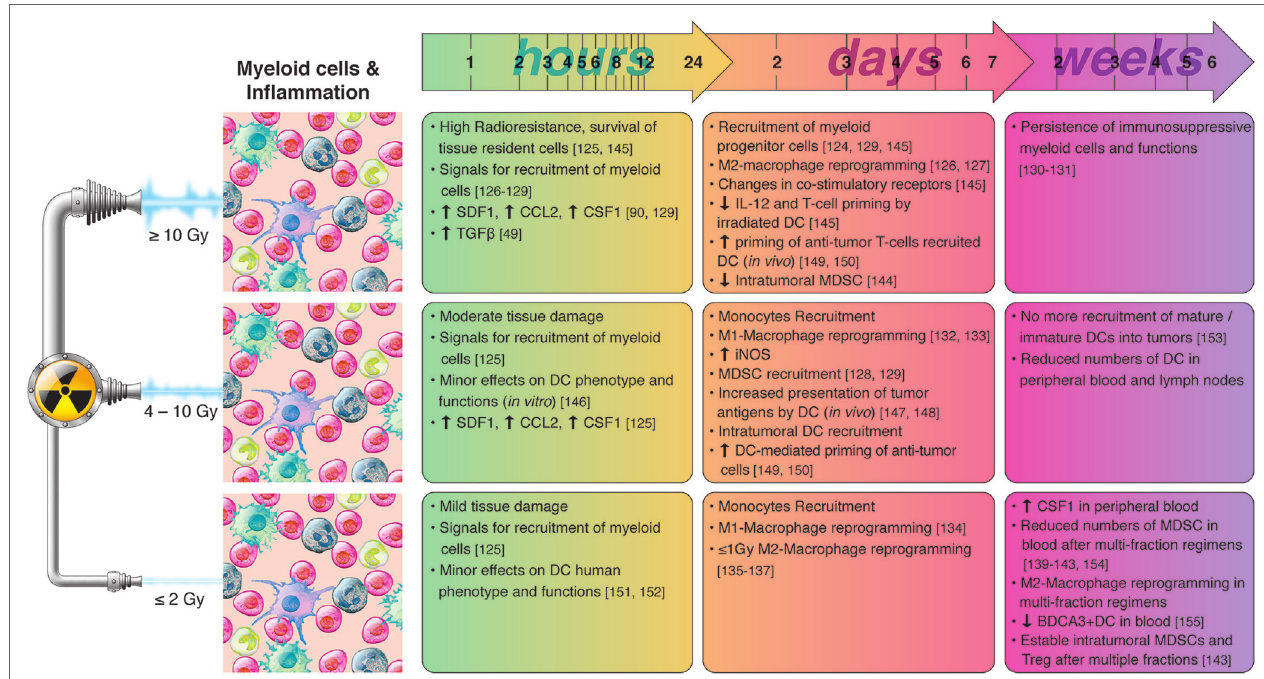
FiGURe 4 | Chronological effects observed on myeloid cells and inflammation after RT delivered at different dose per fraction. The figure is a compilation of observations registered in different experimental models, comprising primary cell cultures (in vitro), cell lines, animal (mainly mice) models, and clinical observations, on effects of RT given at different dose/fraction. Radiation schemes range from single fractions to oligo (daily) fractions and prolonged multifractionated regimens. The vast majority of preclinical observations, using cell cultures and animals, comprise RT regimens of one or few fractions irrespective of the radiation dose. In clinical settings, RT protocols comprising moderate or high doses are always applied in one or few fractionations . In small doses, RT do not affect substantially the phenotype and function of dendritic cells (DCs). However, such doses have been shown to promote M1-polarization of macrophages and monocyte recruitment. The severe tissue damage provoked by high radiation doses induces the rapid release of chemotactic molecules such as CCL2, colony-stimulating factor-1 (CSF1) and SDF-1, and the recruitment of myeloid cells. High radiation doses induce M2 polarization of macrophages, impair the immune-stimulatory functions of tissue resident DCs, and activates de recruitment of myeloid-derived suppressor cell (MDSC). Medium radiation doses also trigger the recruitment of myeloid cells to tumors, however, immune-activating effects preponderate, characterized by M1-polarization of macrophages, and increased presentation of tumor antigens by DC. The mobilization of myeloid cells following RT cease after the first week(s), and it is normal to observe reduced numbers of MDSC, monocytes, or DCs in peripheral blood when prolonged multifraction regimens are